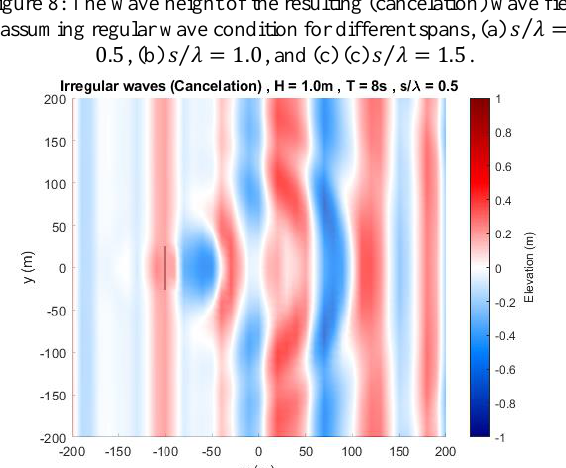
Figure 9: The radiated wave elevation assuming irregular wave condition 𝑠 𝜆⁄ = 0.5 .